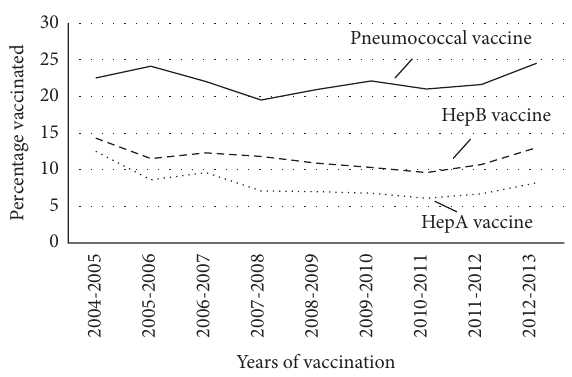
Figure 3: Percentage of cirrhotics with concurrent diabetes vac- cinated between 2004 and 2013. Time represented as years of vaccination (same or following year of cirrhosis